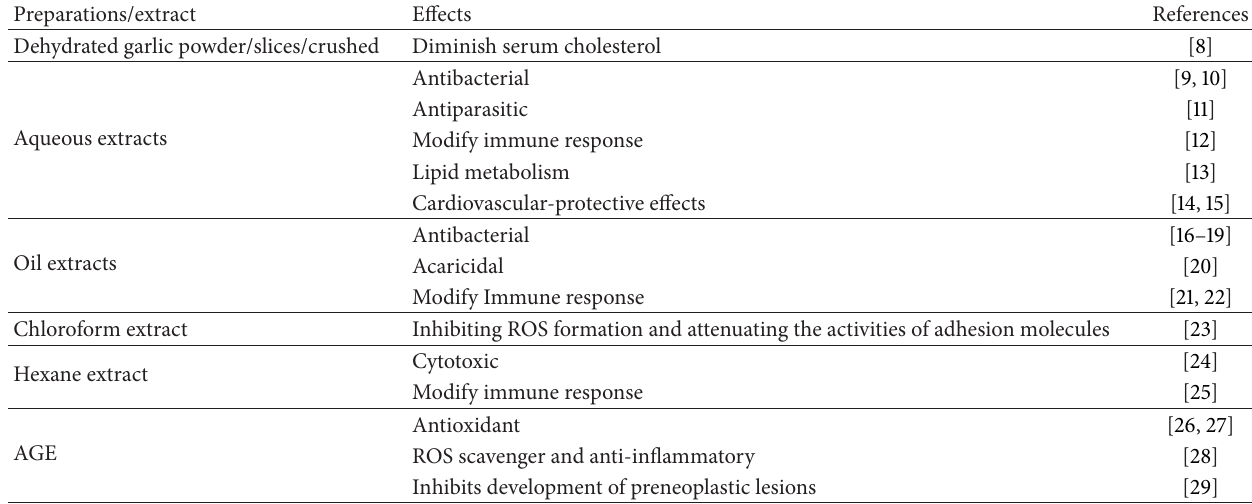
Table 1: Biological effects of different types of garlic preparations and